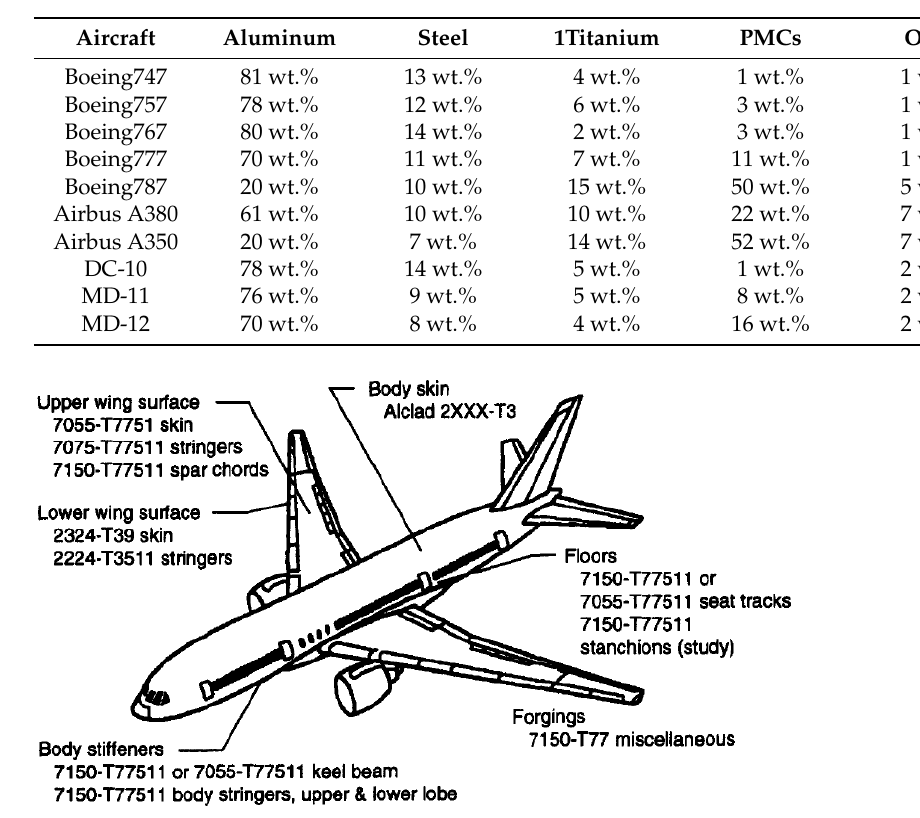
Table 1. Structural material usage in large commercial aircraft [9].